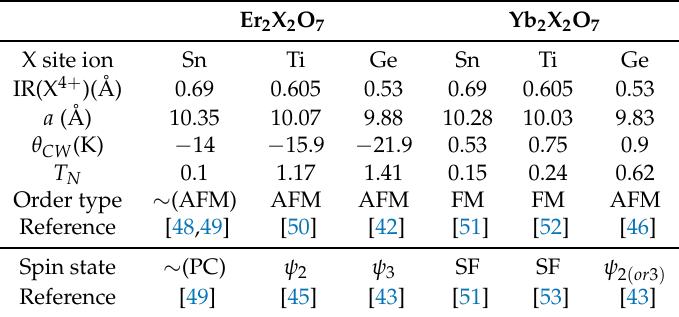
Table 1. Comparison between Er 2 X 2 O 7 and Yb 2 X 2 O 7 .